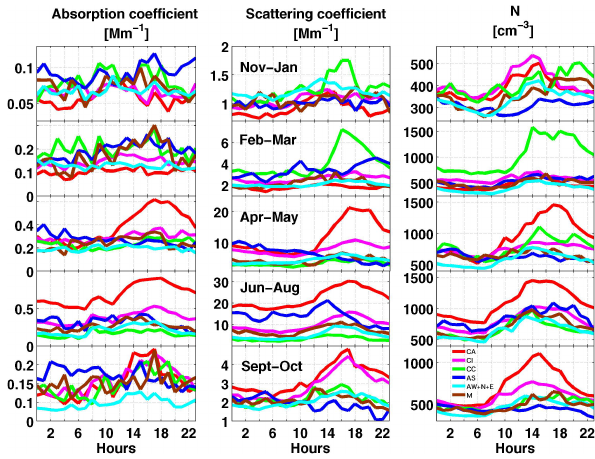
Fig. 6. Median 1995–2008 diurnal cycles of the absorption coef- ficient at λ =880nm, the scattering coefficient at λ =550nm and the aerosol number concentration for 5 defined periods of the year (see middle graph for definition) as a function of SYNALP weather